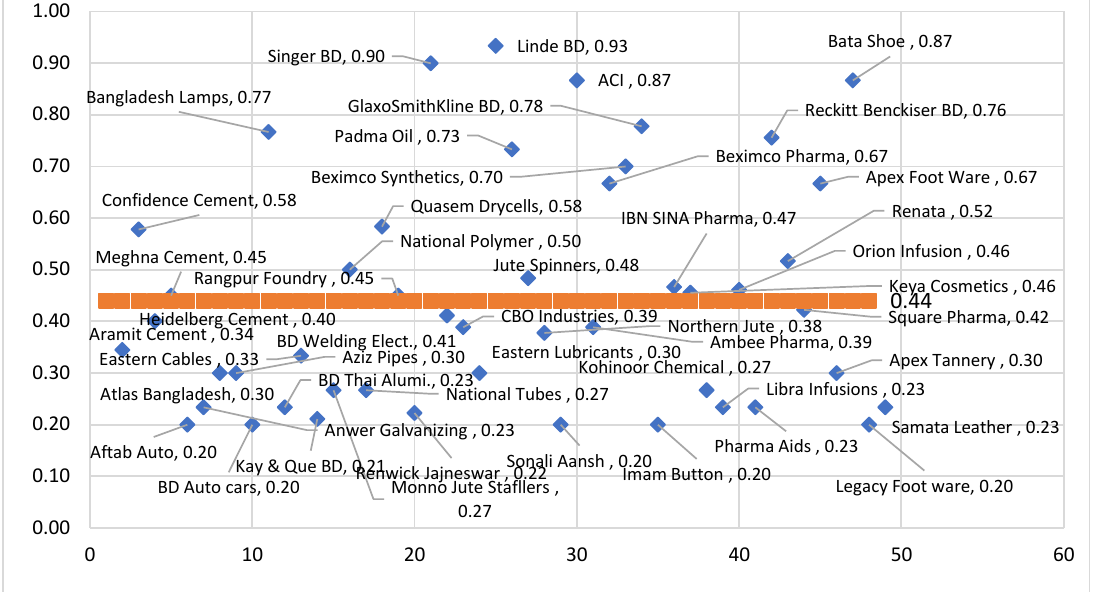
Figure 1. Distribution of overall financial risk disclosure indices during study period for each company in the sample.